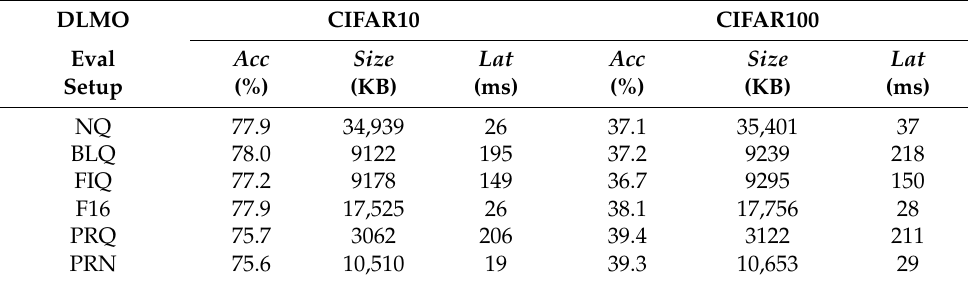
Table 11. MobileNet v3 Large.